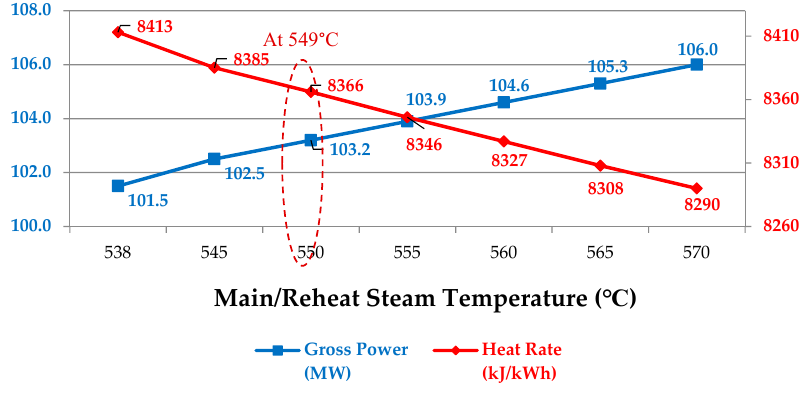
Figure 8. Effect of Main Steam Temperature on Heat Rate and Power Output.